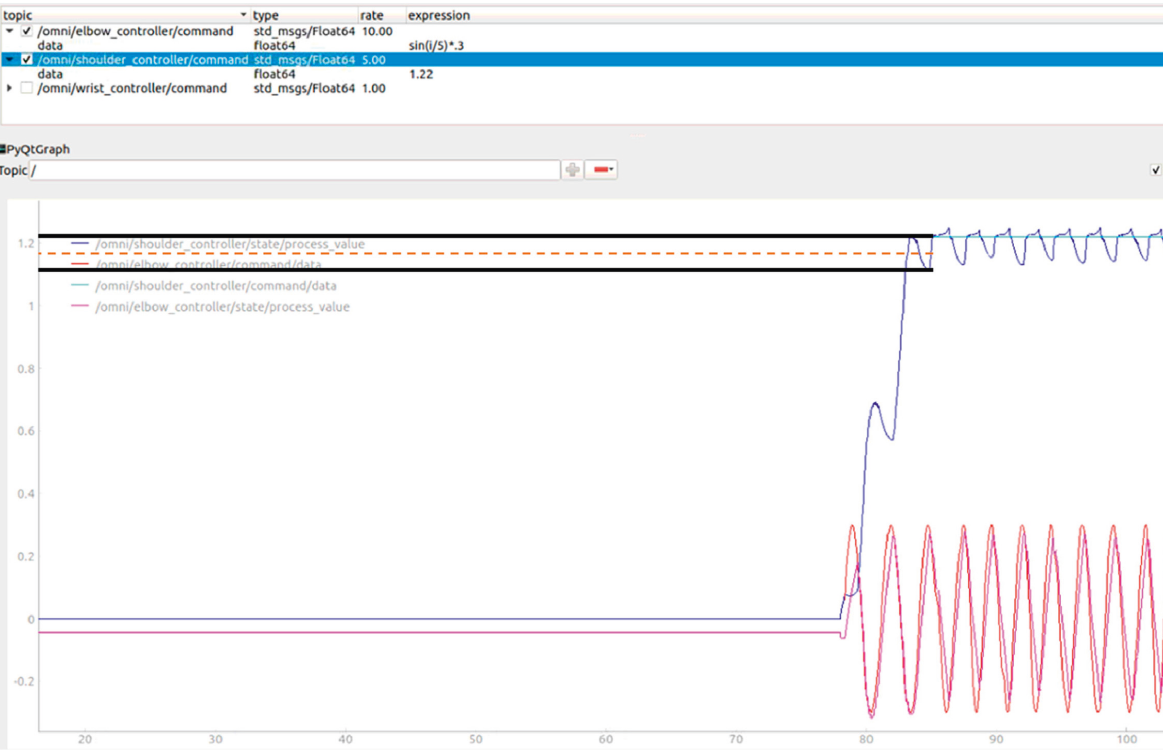
Figure 18: Response of the shoulder joint with